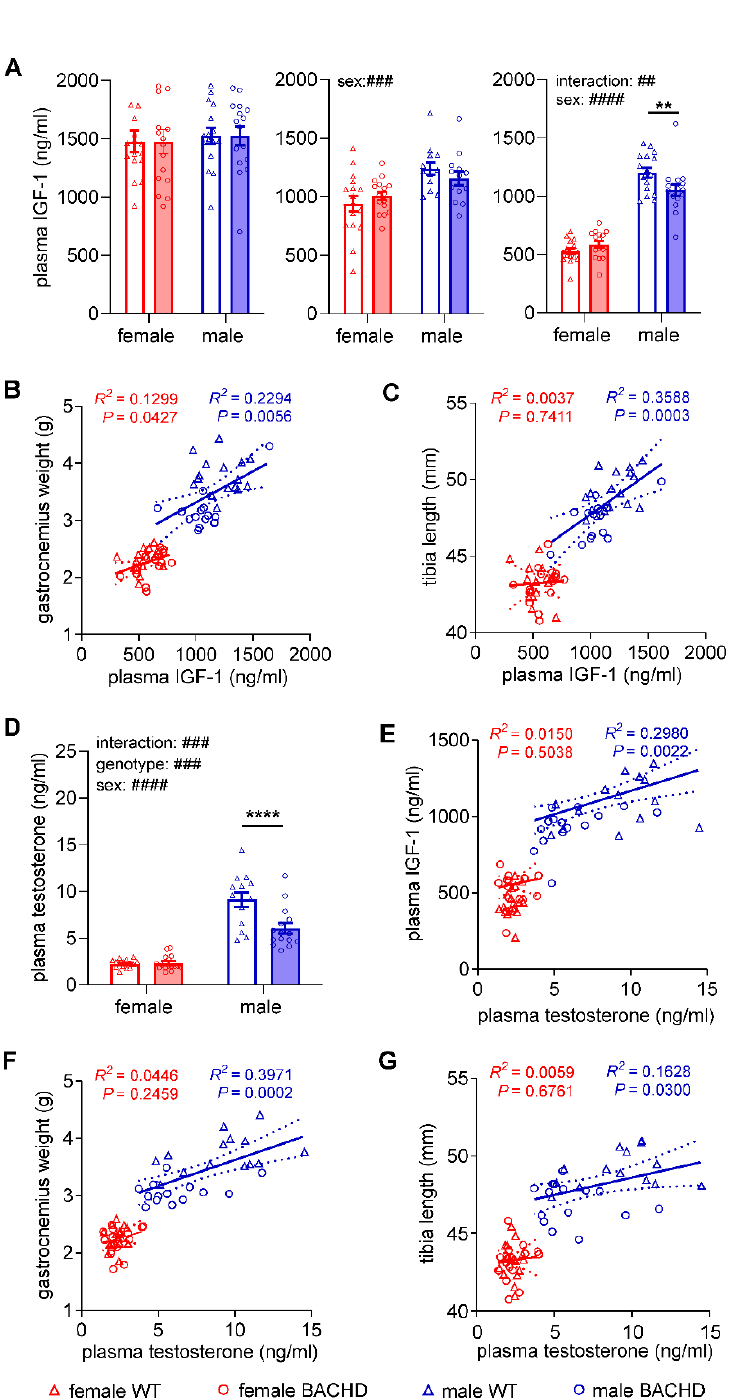
Figure 3. Sex-specific reductions of plasma IGF-1 and testosterone levels correlate with each other and with growth parameters in male BACHD rats at 7 months of age. ( A ) Plasma levels of IGF-1 in young (1.5 months), young adult (3 months) and middle-aged adult (7 months) groups. ( B ) Correlation between plasma levels of IGF-1 and gastrocnemius weight in female and male rats in the middle-aged group (7 months). ( C ) Correlation between plasma levels of IGF-1 and tibia length in female and male rats in the middle-aged group (7 months). Plasma levels of testosterone ( D ) in the middle-aged group (7 months). ( E ) Correlations between plasma levels of testosterone and IGF-1 (7 months). ( F ) Correlation between plasma levels of testosterone and the weight of gastrocnemius (7 months). ( G ) Correlation between plasma testosterone levels and tibia length (7 months). For all analyses n = 12–16/genotype/sex/age. In A and D: data are expressed as mean values ± SEM; statis- tical significance was determined by regular two-way ANOVA followed by Sidak’s post-hoc test. # indicates the results of two-way ANOVA analysis; * indicates the results of post-hoc test. ##/** p ≤ 0.01; ### p ≤ 0.001; #### /**** p ≤ 0.0001. In ( B , C , E – G ): data are represented as individual values